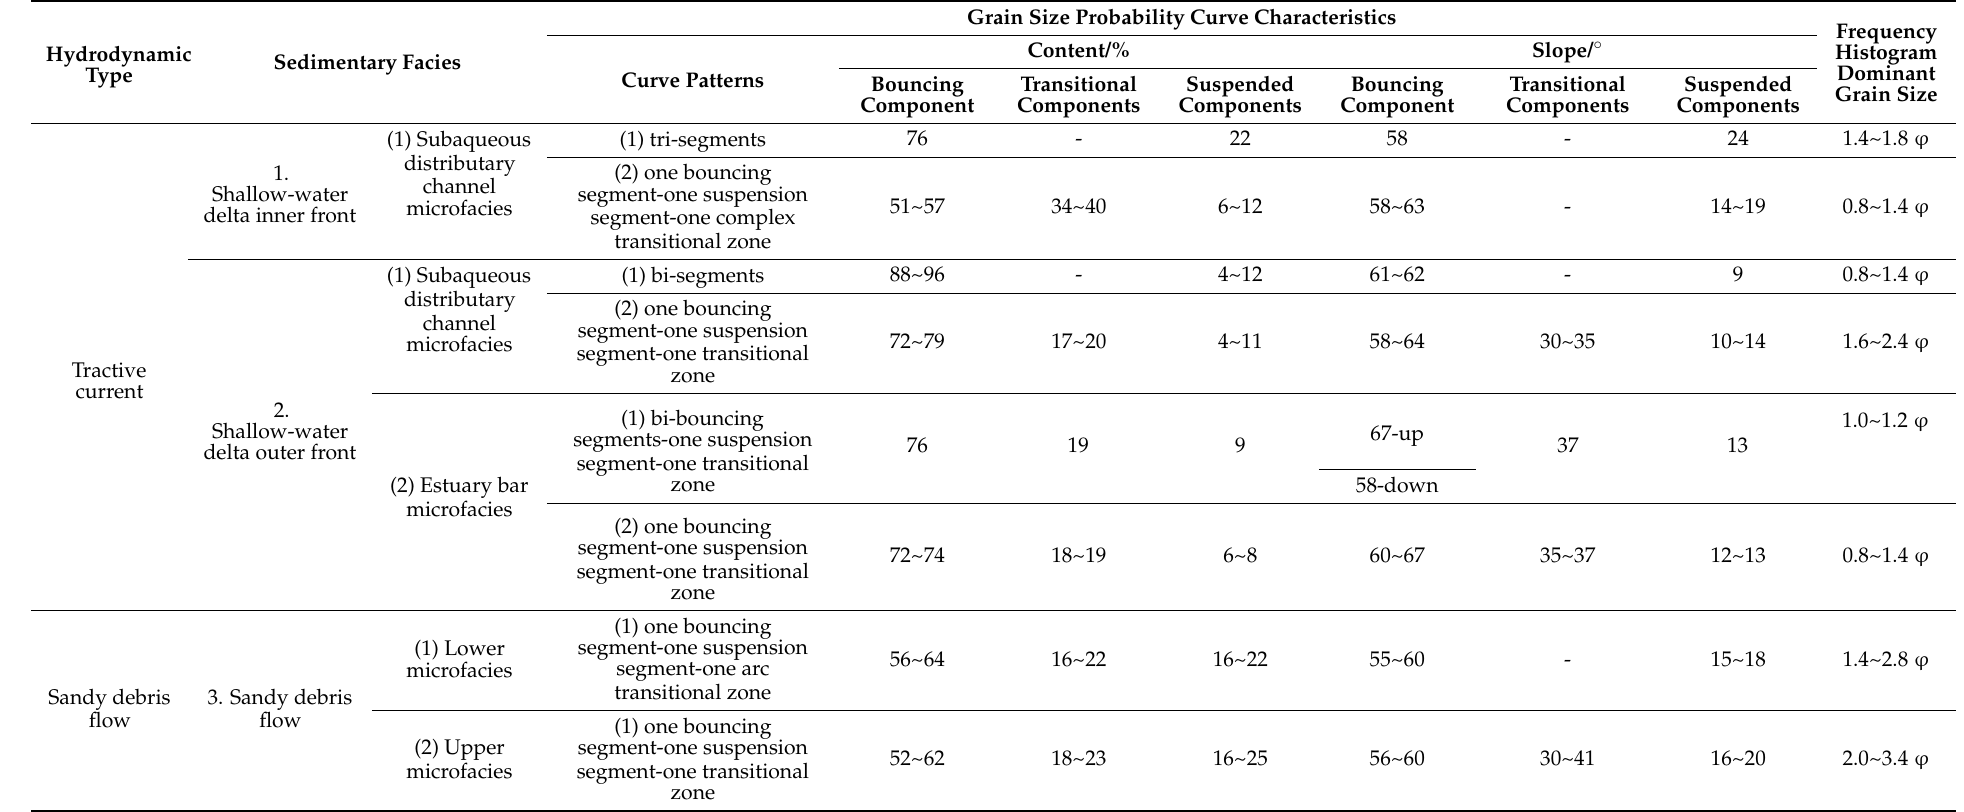
Table 1. Comparison of grain-size curves of different sedimentary